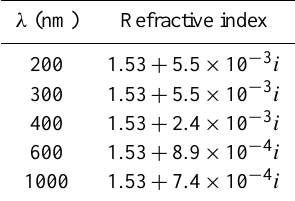
Figure 3. Modelled total (black line) and stratospheric (blue line) ozone column above Lampedusa, expressed in Dobson units (DU), compared to the measured values (red circles). Table 2. Refractive indices used for mineral